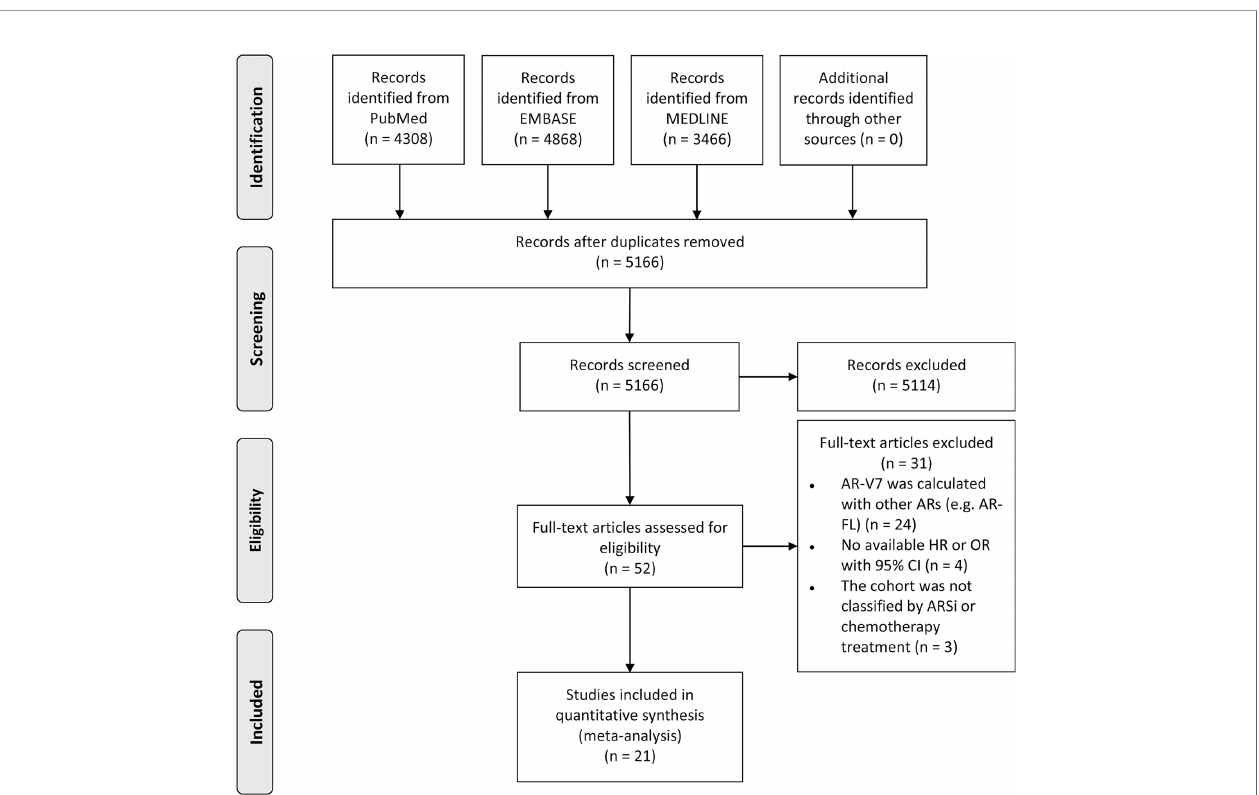
FIGURE 1 | PRISMA fl ow diagram of literature screening. AR-V7, androgen receptor splice variant 7; AR, androgen receptor; AR-FL, full-length androgen receptor; HR, hazard ratio; OR, odds ratio; CI, con fi dence interval; ARSi, androgen receptor signaling